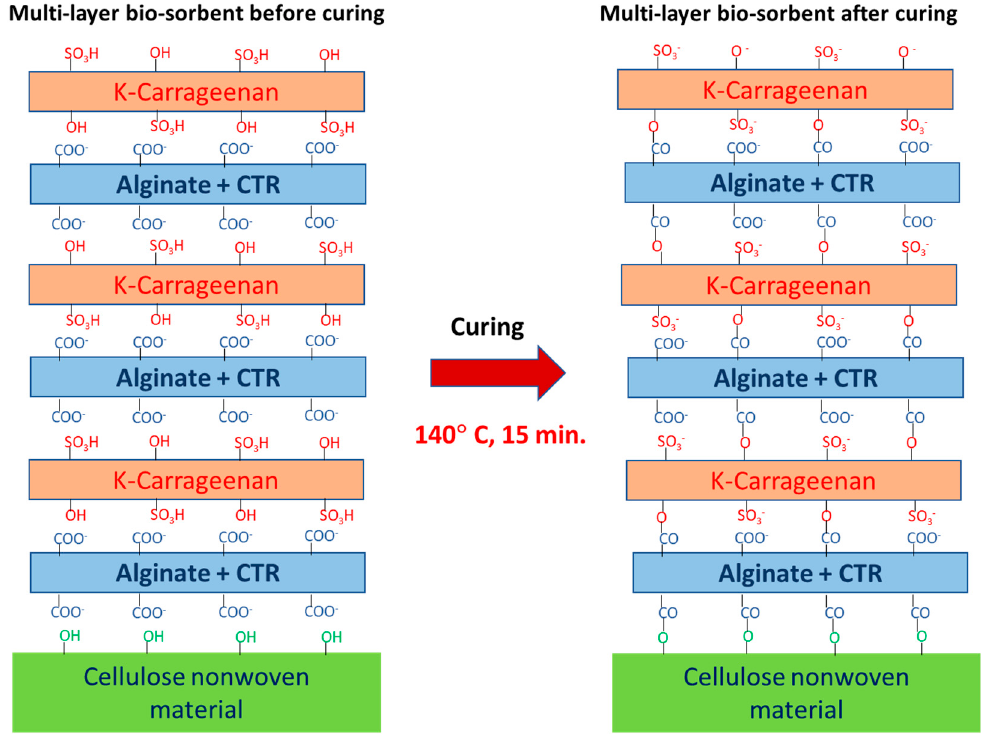
Figure 1. Illustration of the functionalization of cellulosic material upon polyesterification reactions via CTR (Citric acid) crosslinking, leading to the polyanionic PEM bio-sorbent system after curing at 140 °C for 15 min.